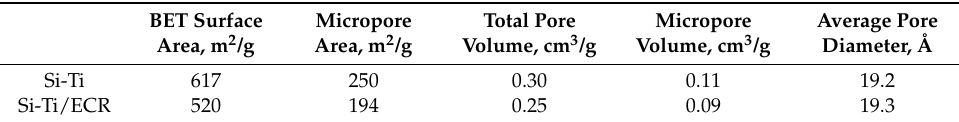
Table 2. Comparison of textural characteristics of unmodified silica–titania xerogel (Si-Ti) and sensor material (Si-Ti/ECR).